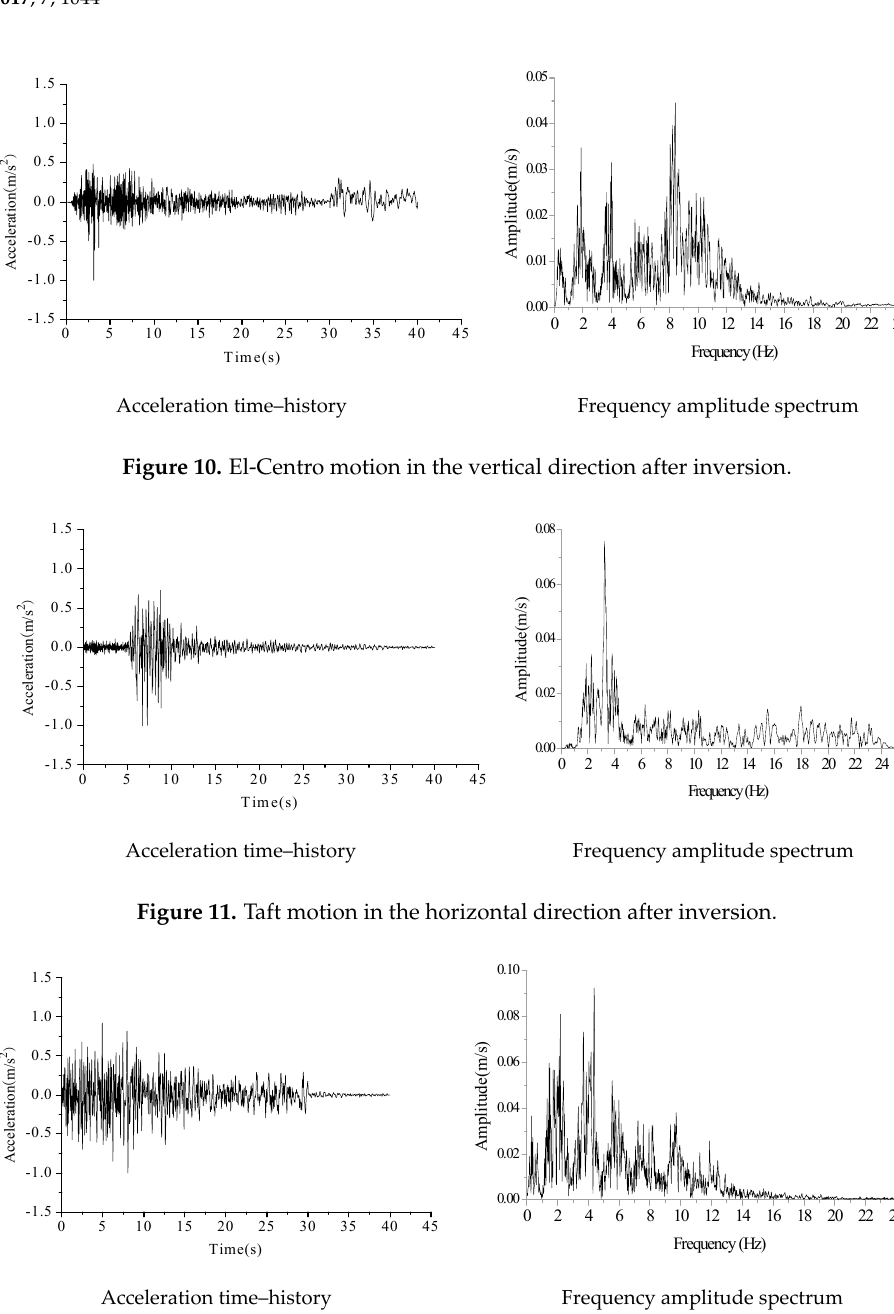
8 of 24 Figure 8. Finite element model of soil. According to the classification of site type and seismic fortification intensity, three earthquake records—El-Centro record, Taft record and Lanzhou record—were derived from the registered seismic data. Moreover, in order to obtain earthquake motions, three earthquake records were back-calculated to the bottom of the foundation level by the SHAKE91 procedure (Idriss et al., 1992 [37]). According to the finite element division of the soil layer, soil properties such as density, shear velocity, shear modulus of elasticity, etc., were taken into account in earthquake motion inversion. Time-histories and spectra of these records after inversion are shown in Figures 9–14.